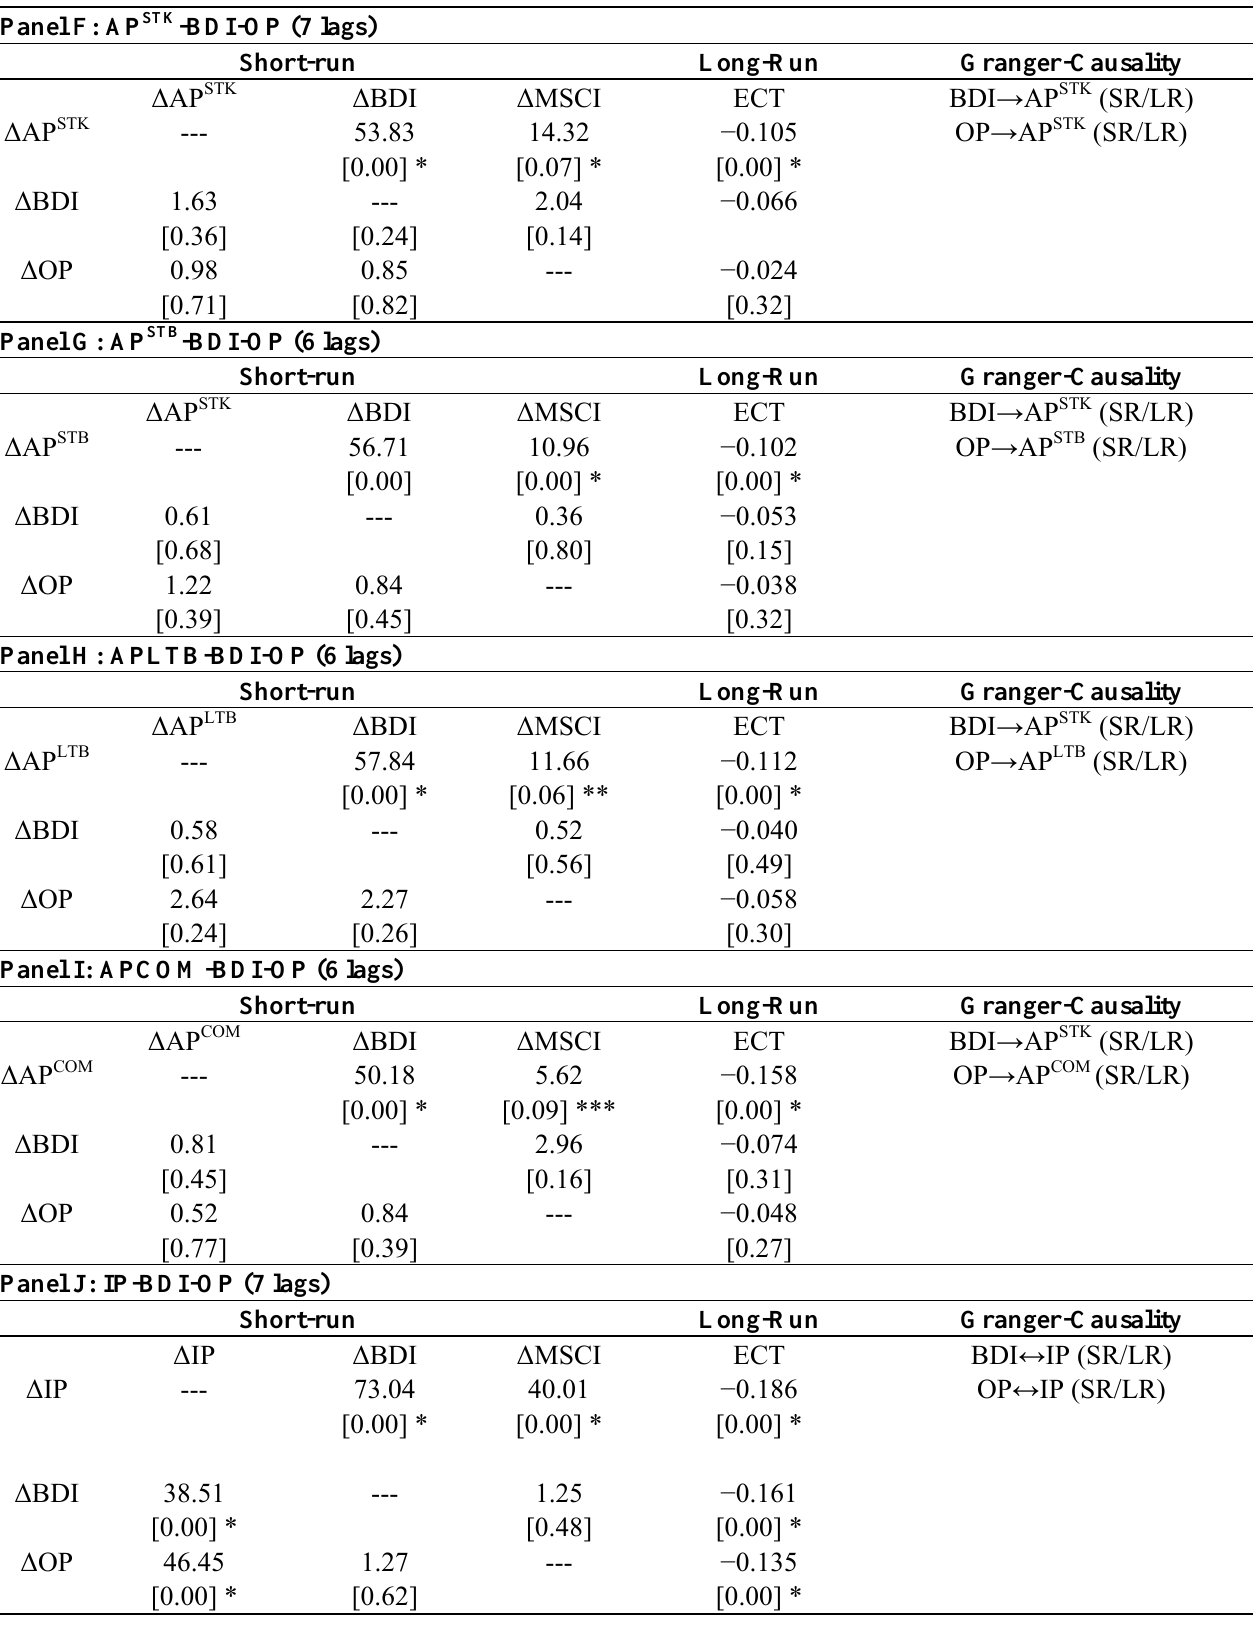
Panel J: IP-BDI-OP (7